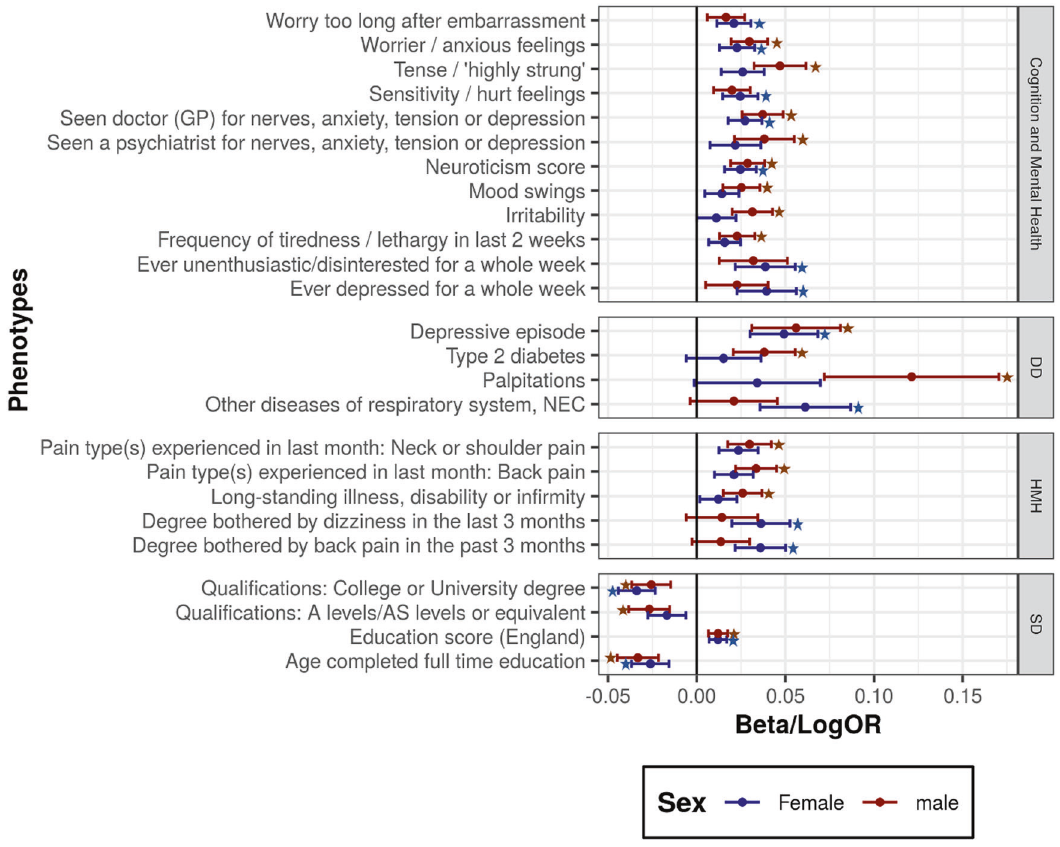
Fig. 5 Phenotypes signi fi cantly associated with TS PRS in either males or females; asterisk (*) indicates signi fi cant after multiple testing correction. The x-axis shows the Beta (effect size) of association between the phenotype and the genetic risk of TS in females and males. DD Disease Diagnosis, HMH Health and Medical History, SD